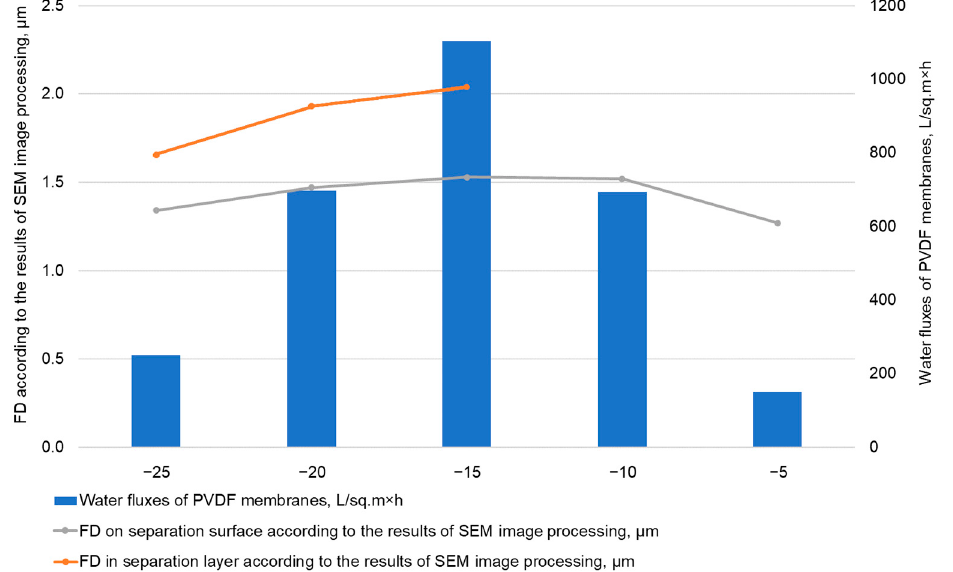
Figure 5. XRD spectra of membranes produced at different freezing temperature.